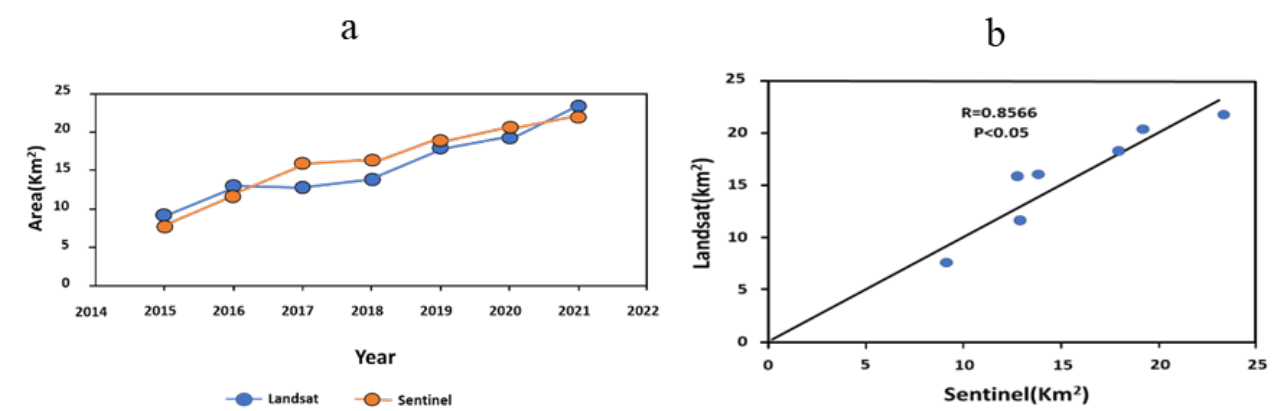
Figure 6. ( a ) The increase in the vegetated areas detected by Landsat 8 and Sentinel 2A data during the period from 2015 to 2021; ( b ) The correlation between remote sensing datasets (based on NDVI index).